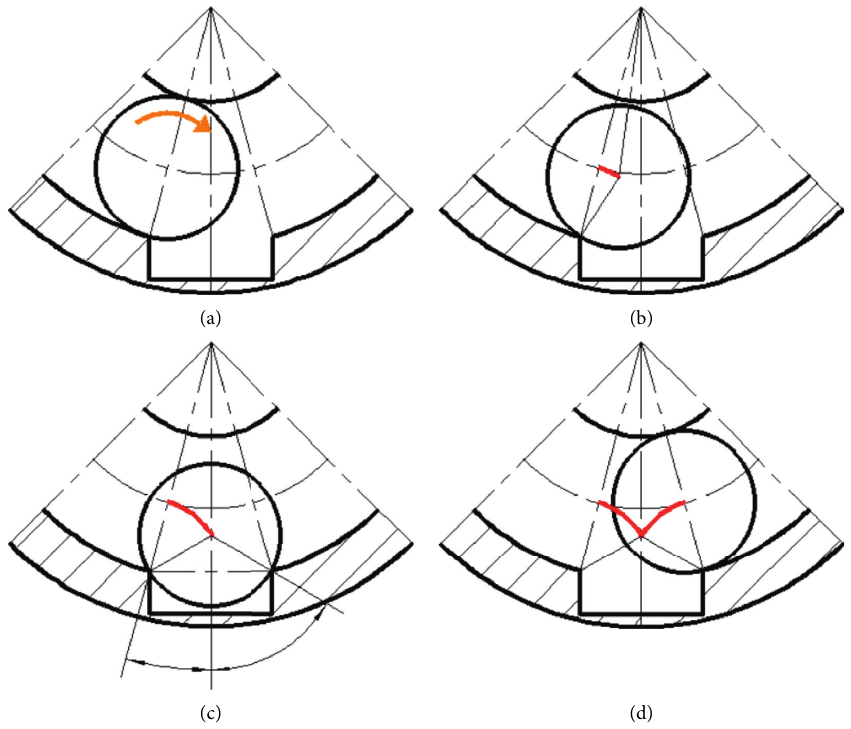
Figure 1: Additional displacement path of rolling bearing local